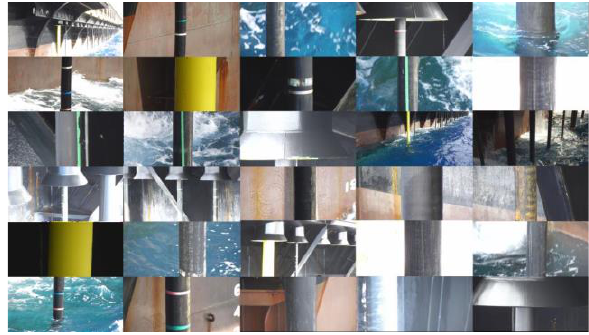
Figure 4. Real dataset for risers inspection process.